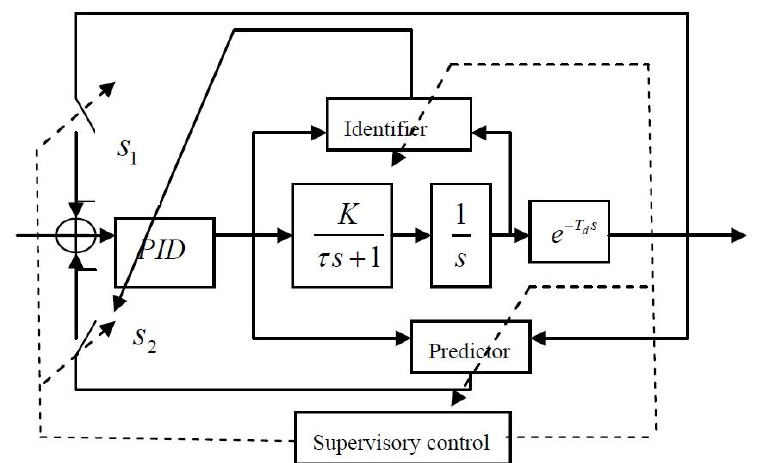
Figure 8. Controller with